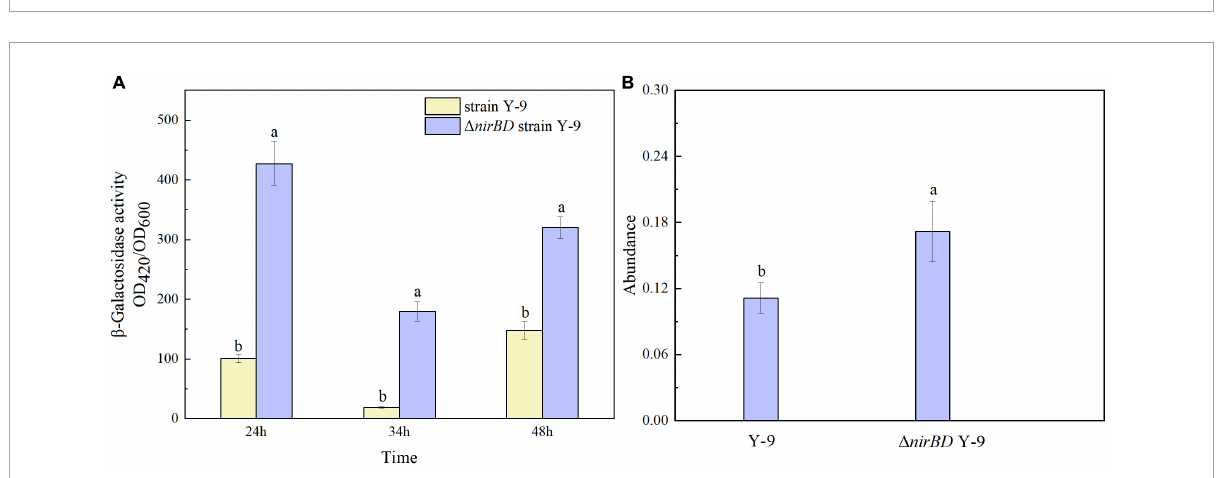
FIGURE2 The growth curve and nitrogen transformation performance of strain Y-9 in nitrification medium at 15 ◦ C. (A) The wild-type strain Y-9. (B) The (cid:77) nirBD strain Y-9.